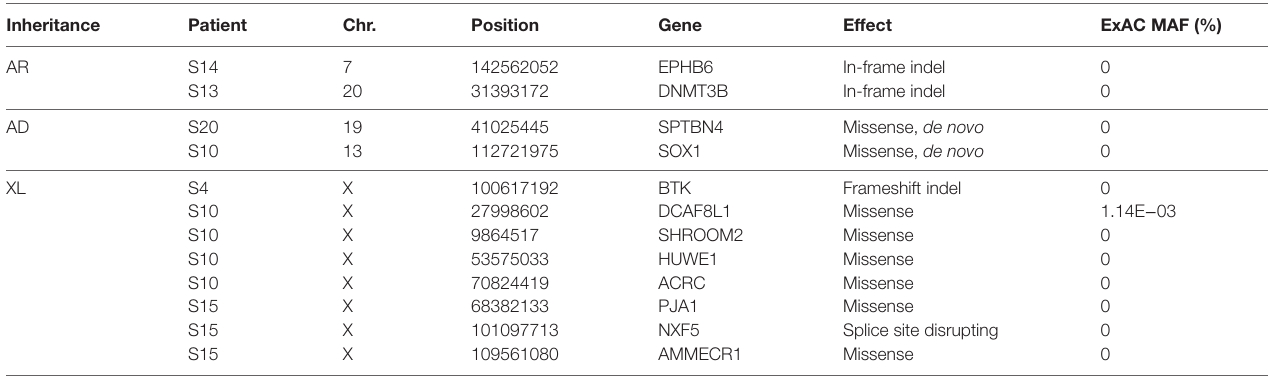
TaBle 4 | Potentially causal variants (see Materials and Methods for details) identified in 6 of the 11 previously healthy children with community-acquired Pseudomonas aeruginosa